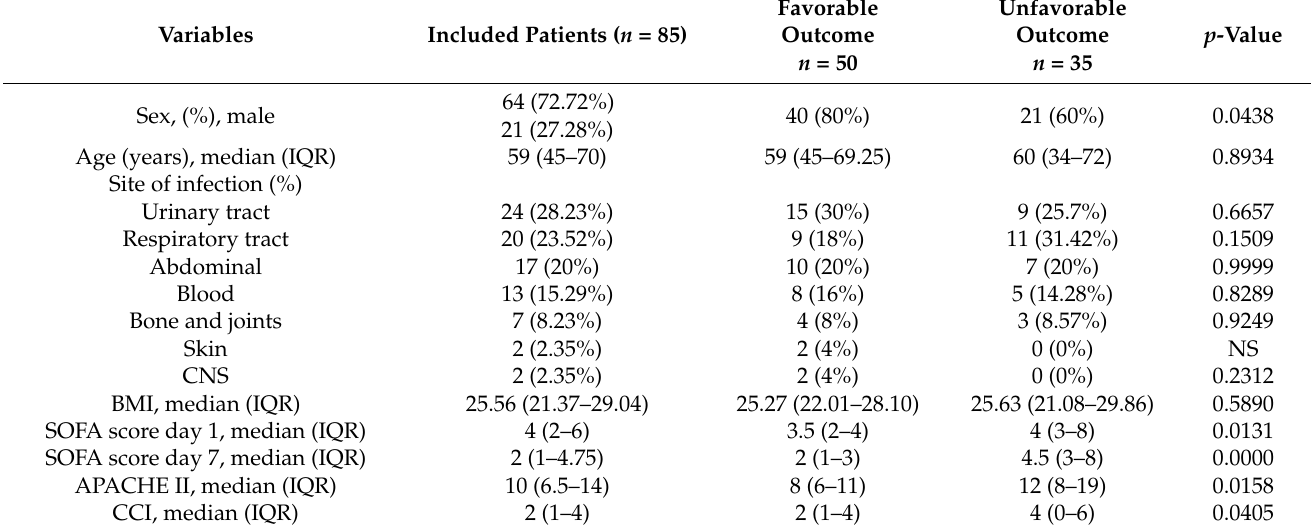
Table 1. Demographic characteristics and clinical outcomes for the 85